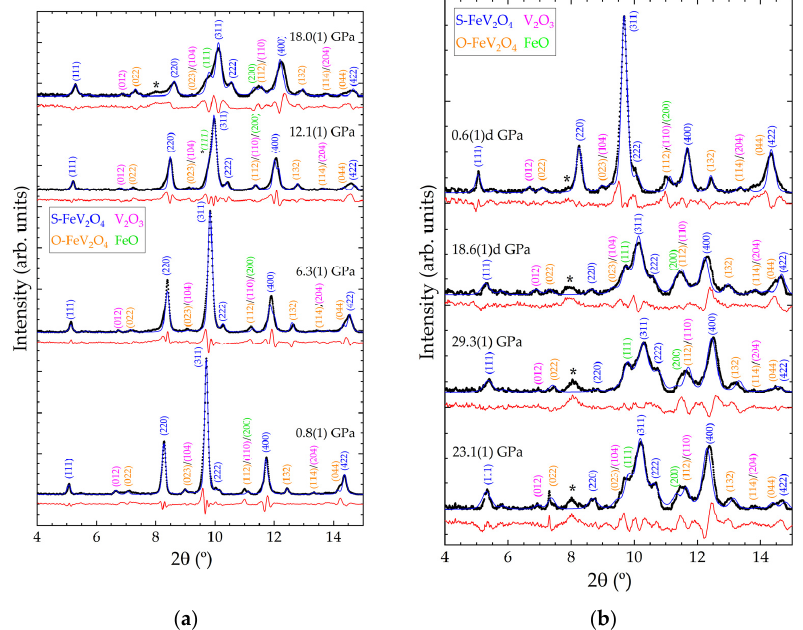
Figure 3. XRD patterns from FeV 2 O 4 sample at selected pressures. ( a ) Increasing pressure from 0.8(1) to 18.0(1) GPa. ( b ) Increasing pressure from 23.1(1) GPa to the maximum pressure, 29.3(1) GPa, fol- lowed by decompression to 0.6(1) GPa. Observed data are shown with black symbols. Le Bail pro- files and residuals are shown with blue and red lines, respectively. Relevant reflections are indicated with their Miller indices, with the colour of the text matching with the phases as indicated in the legend. Pressures are indicated in the figure. The letter ‘d’ after the labelled pressure corresponds to data acquired on sample decompression. The asterisk ‘*’ marks the unindexed reflection which begins to emerge at 18 GPa.